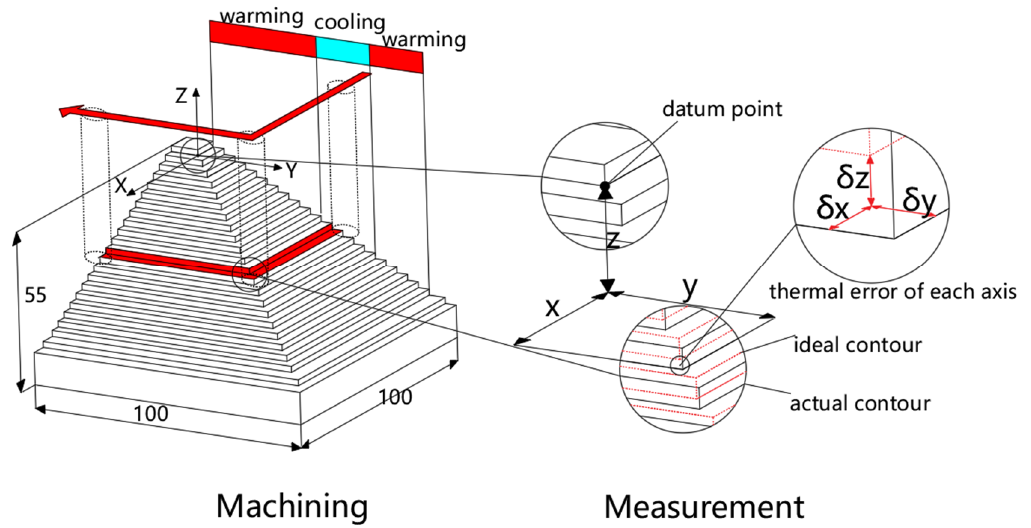
Figure 13. Measured positioning thermal error. ( a ) X-axis without compensation. ( b ) Y-axis without compensation. ( c ) Z-axis without compensation. ( d ) X-axis with compensation (1st). ( e ) Y-axis with compensation (1st). ( f ) Z-axis with compensation (1st). ( g ) X-axis with compensation (2nd). ( h ) Y- axis with compensation (2nd). ( i ) Z-axis with compensation (2nd). ( j ) X-axis with compensation (3rd). ( k ) Y-axis with compensation (3rd). ( l ) Z-axis with compensation (3rd).